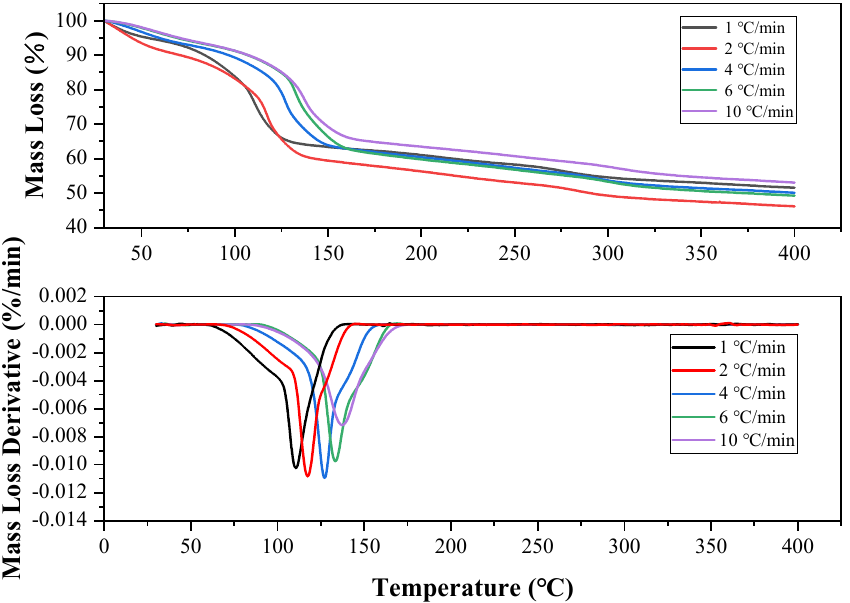
Figure 6. TG-DTG curve of lithiated anode with BL-TCN electrolyte at different β .